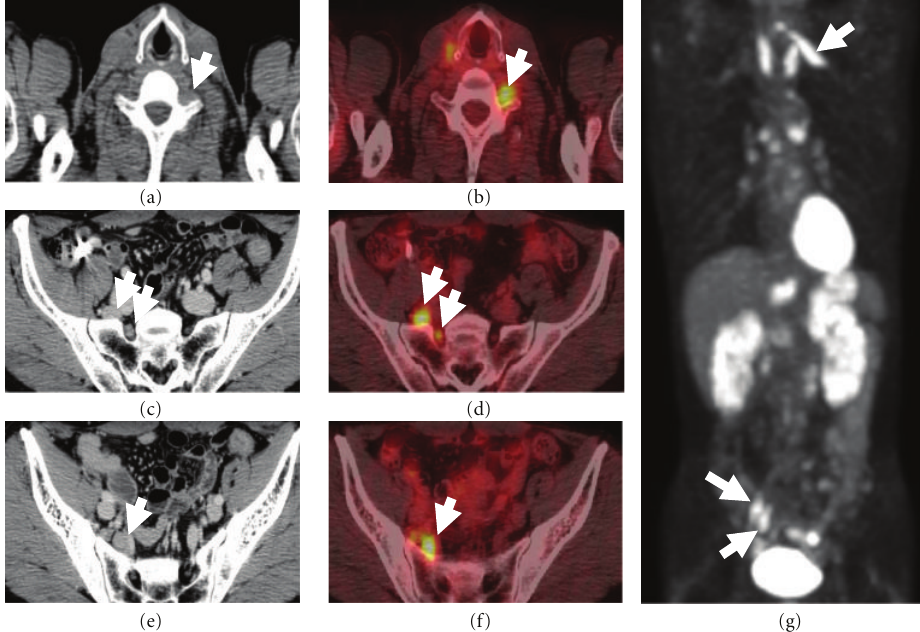
Figure 4: CT (a, c, and e) and FDG-PET (b, d, and f: fusion images; g: coronal MIP image) of whole body in 58-year-old man (case 5). CT shows soft tissue density around the left C6 (a; arrow), right L5 (c; arrows), and S1 nerves (e; arrow). High FDG uptakes are identified as perineural masses (b, d, f, and g; arrows).